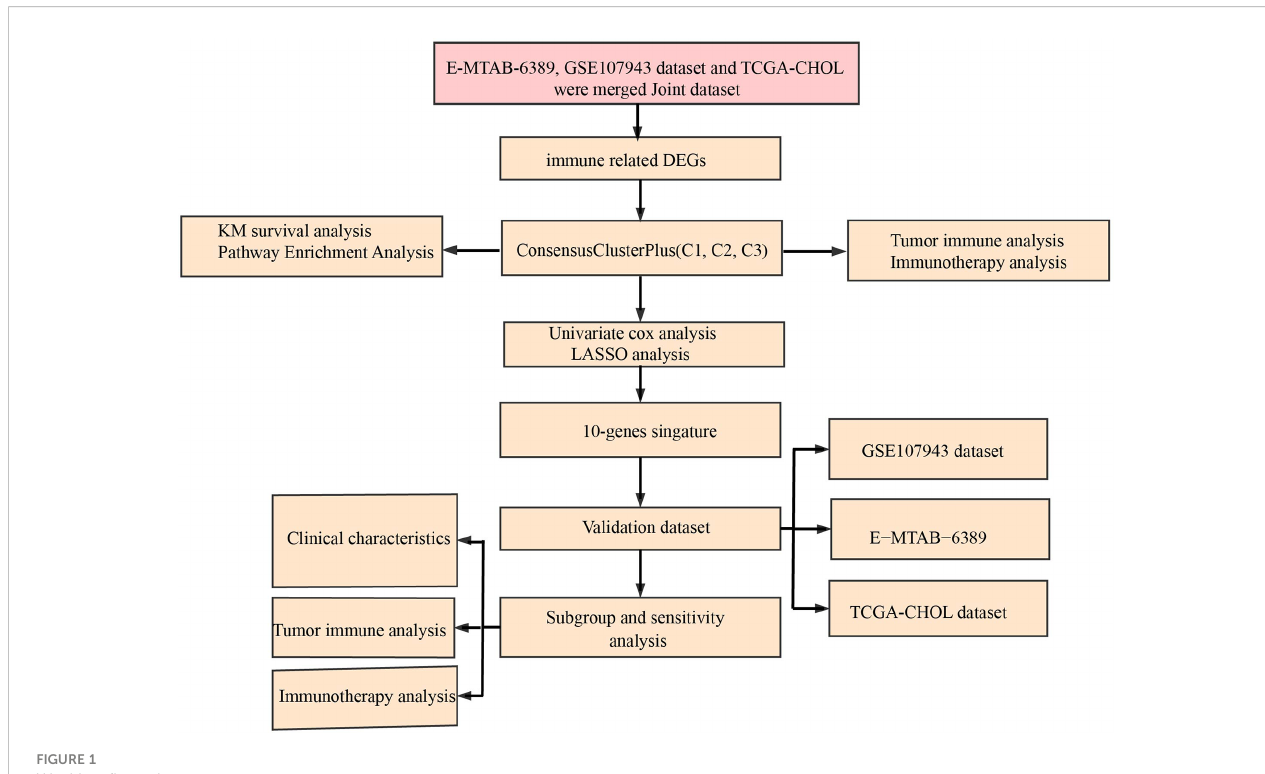
FIGURE 1 Working fl ow chart.